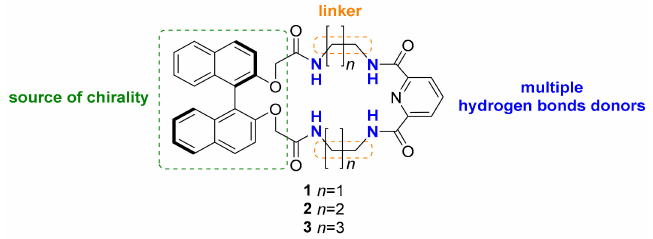
Figure 1. Structure of BINOL–based macrocyclic receptors ( R )-1–3 investigated